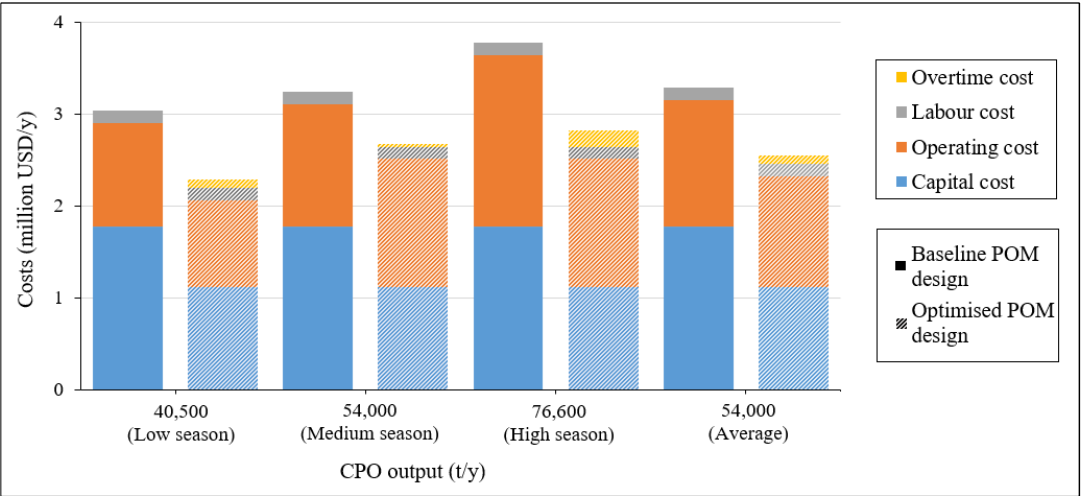
Figure 5. Costs allocation for a baseline against optimised palm oil mill design.